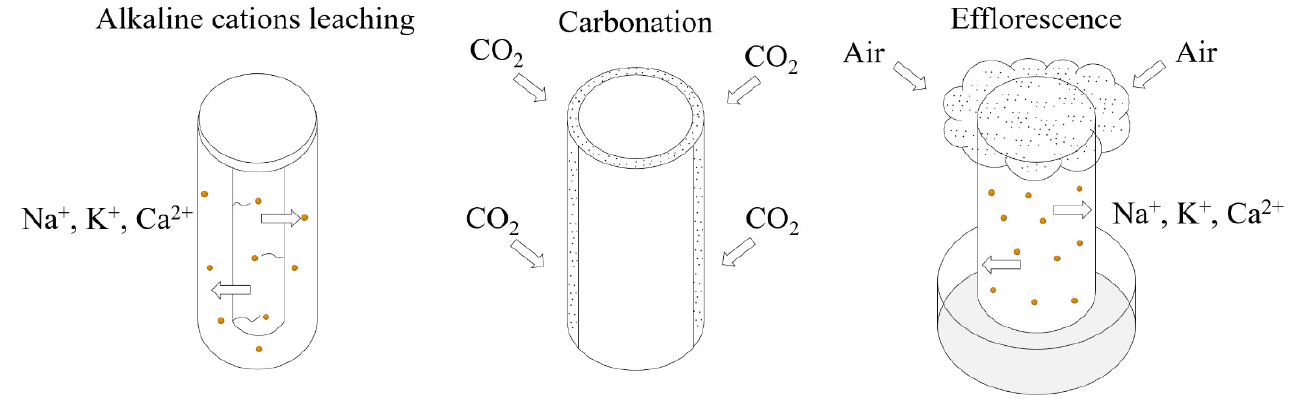
Figure 4. The testing methods of alkaline cation leaching, air carbonation, and efflorescence.